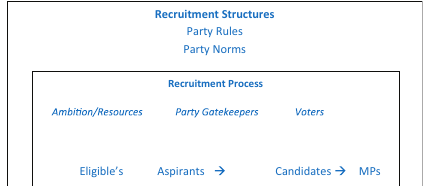
Figure 1. Adapted from Matland and Montgomery (2003), recruiting women to national legislature.